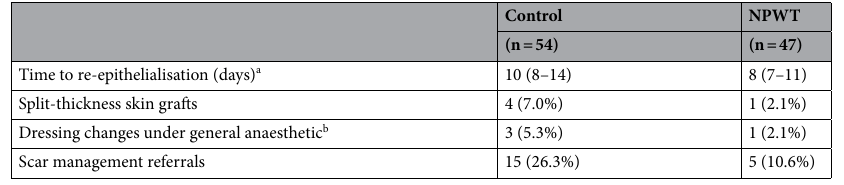
Table 1. Clinical outcomes for each treatment group. Values are n (%) unless indicated otherwise. a Median (IQR). b Undertaken in participants at either their second or third clinical visit.